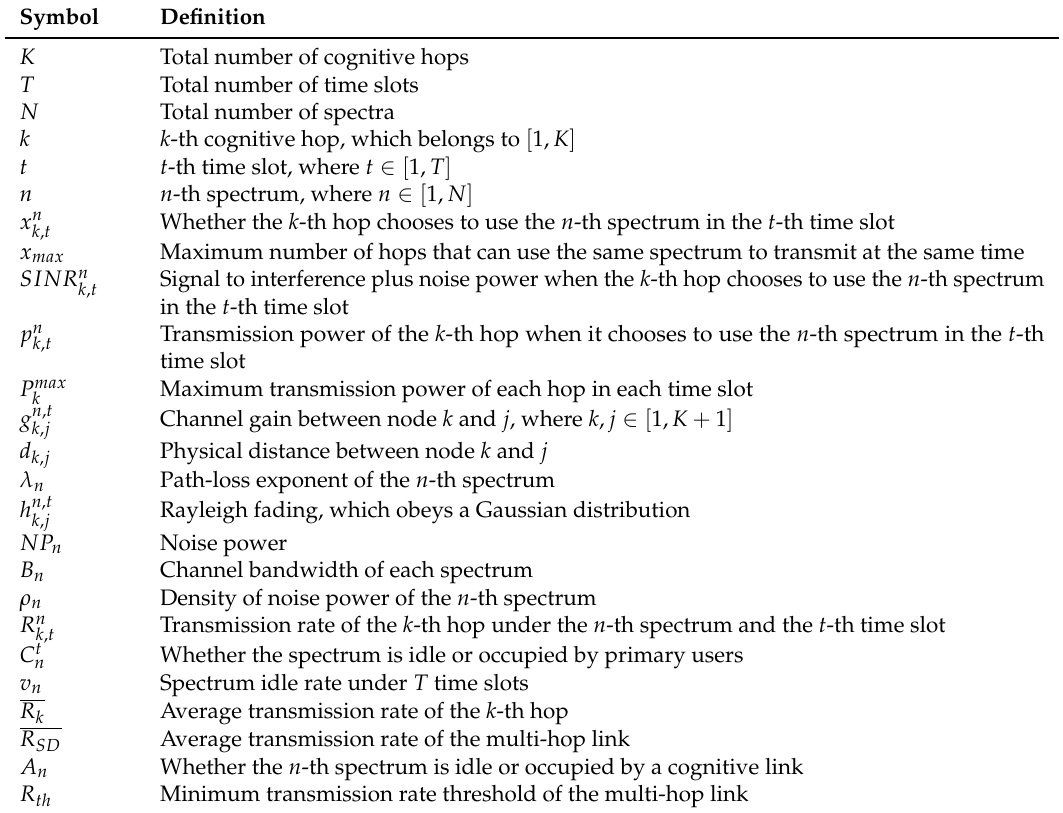
Table 1. Important